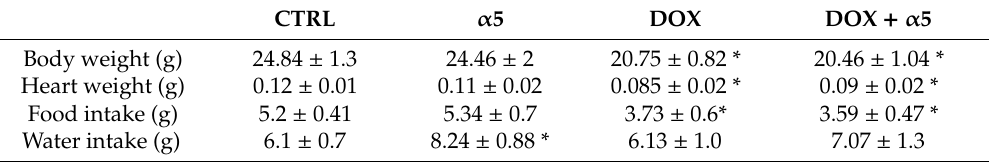
Table 3. Body weight, heart weight, food intake, and water